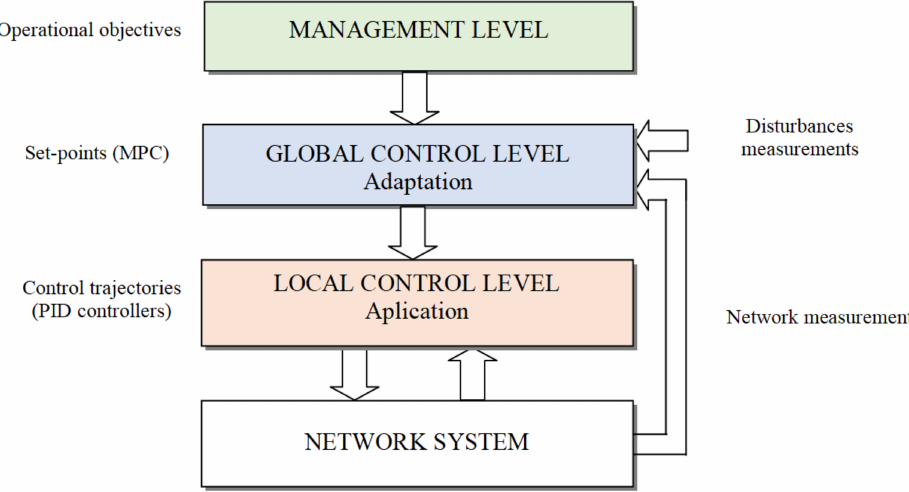
Figure 5. Hierarchical control